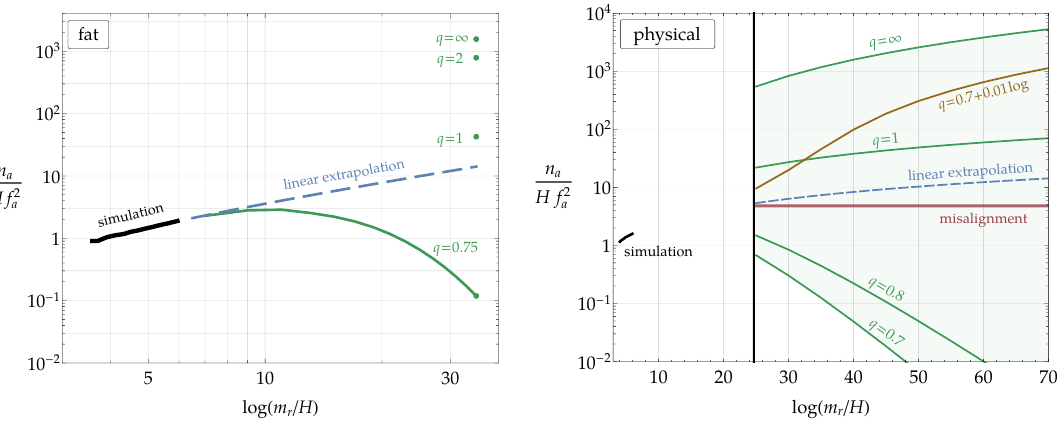
Figure 13 . Possible extrapolations of the axion number density to large values of the log with di(cid:11)erent assumptions about the late time behaviour of the power q of the instantaneous emission spectrum. For the fat string case (left) we compare a naive linear extrapolation of n a to that assuming q = 0 : 75 remains constant. We also show the late time number densities if q changes to 1, 2, or 1 at an intermediate value of the log. For the physical case (right) we only show extrapolations in the range log & 23 (cid:4) 70, corresponding roughly to the values of m r in the range keV (cid:4) 10 11 GeV, which are not excluded by (cid:12)fth force experiments and star cooling bounds. In addition to constant values q = 0 : 75, 1, 2 and 1 , we plot the e(cid:11)ect of a small logarithmic scaling violation q = 0 : 75 + 0 : 01 log ( m r =H